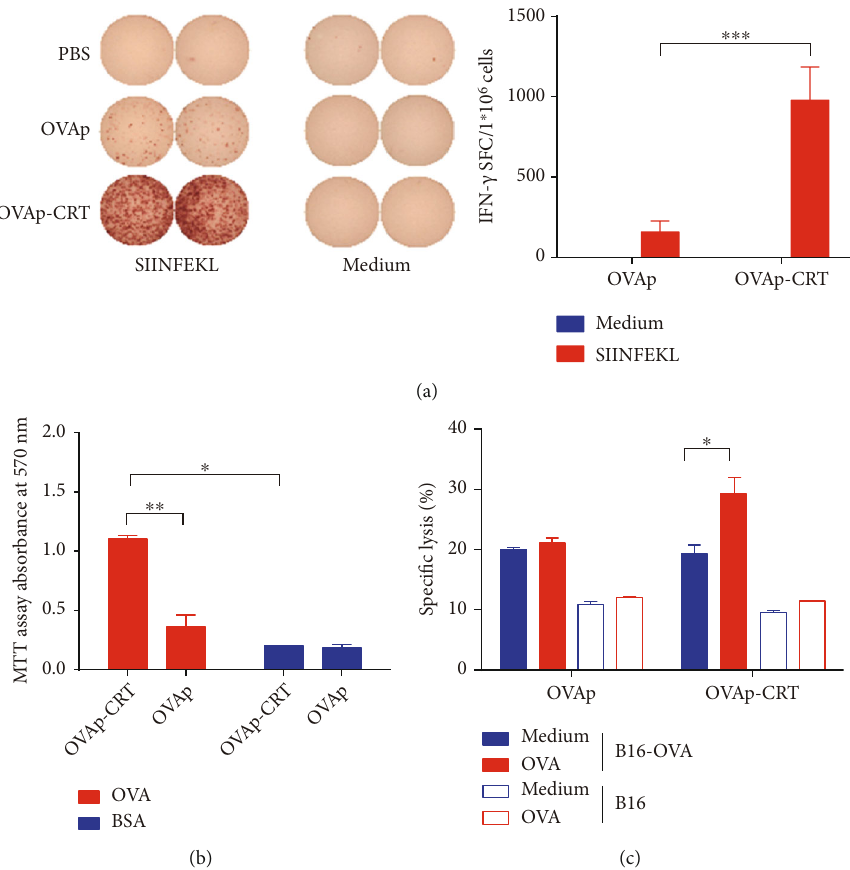
Figure 3: CRT/39-272 exerts an adjuvant e ff ect on OVAp-induced T cell di ff erentiation and function. C57BL/6 mice were immunized subcutaneously with OVAp or OVAp-CRT on days 0, 7, and 14. Splenocytes harvested from immunized mice on day 21. (a) Splenocytes were restimulated with or without SIINFEKL (0.5 μ g/mL) for 24 h. IFN- γ secreting cells were determined by IFN- γ ELISpot assay. (b) Splenocytes were restimulated with OVA or BSA (10 μ g/mL) for 3 days. Cell proliferation from restimulated splenocytes was measured. (c) Splenocytes were restimulated with or without OVA (10 μ g/mL) for 24 h, and then, CFSE-labeled B16 or B16-OVA cells were added. After 4h coculture, the cells were removed, and the dead tumor cells were determined by fl ow cytometry. The results were replicated three times with a consistent trend. Data are representative of at least three independent experiments. ∗ p < 0 : 05 . ∗∗ p < 0 : 01 . ∗∗∗ p < 0 : 001